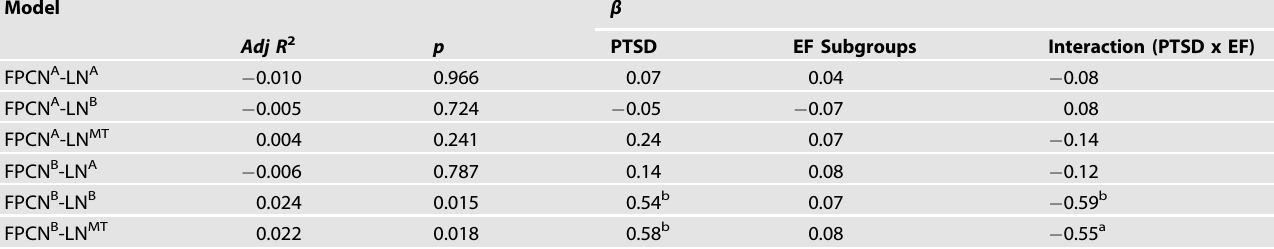
Table 2. Subnetwork connectivity differences between EF subgroups of PTSD.